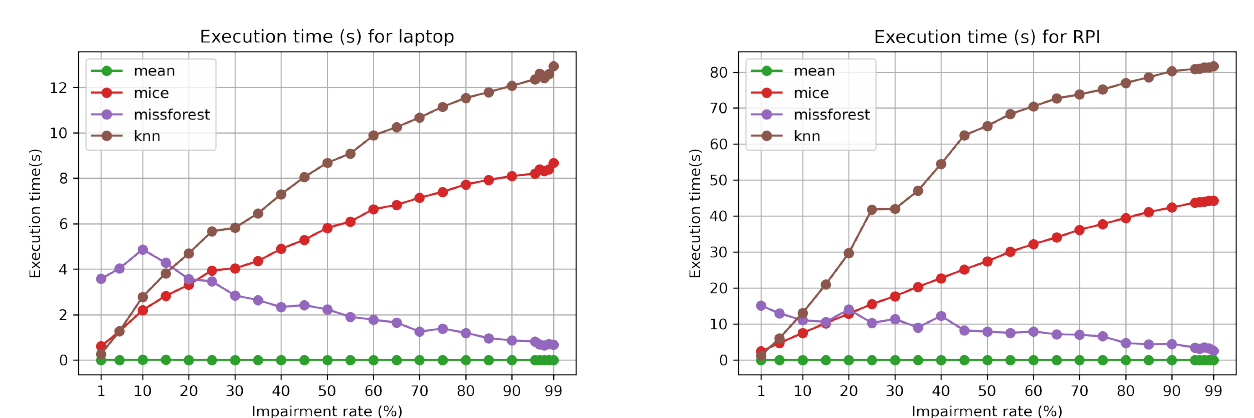
Figure 7. Execution times (s) on laptop and RPI 4B 4GB for the non-bursty case and varying impairment rates.